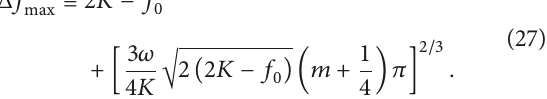
Figure 3: The exact numerical solution of the current (solid curve) and the adiabatic approximation (dotted curve). The simulations parameters were 𝐿√𝑈 = 7 , 𝑓 0 /√𝑈 = 0.5 , Ω/𝑈 = 0.5 , 𝜔/𝑈 = 0.01 , and Δ𝑓 𝑟 = 2𝐾 − 𝑓 0 ≅ 0.9142